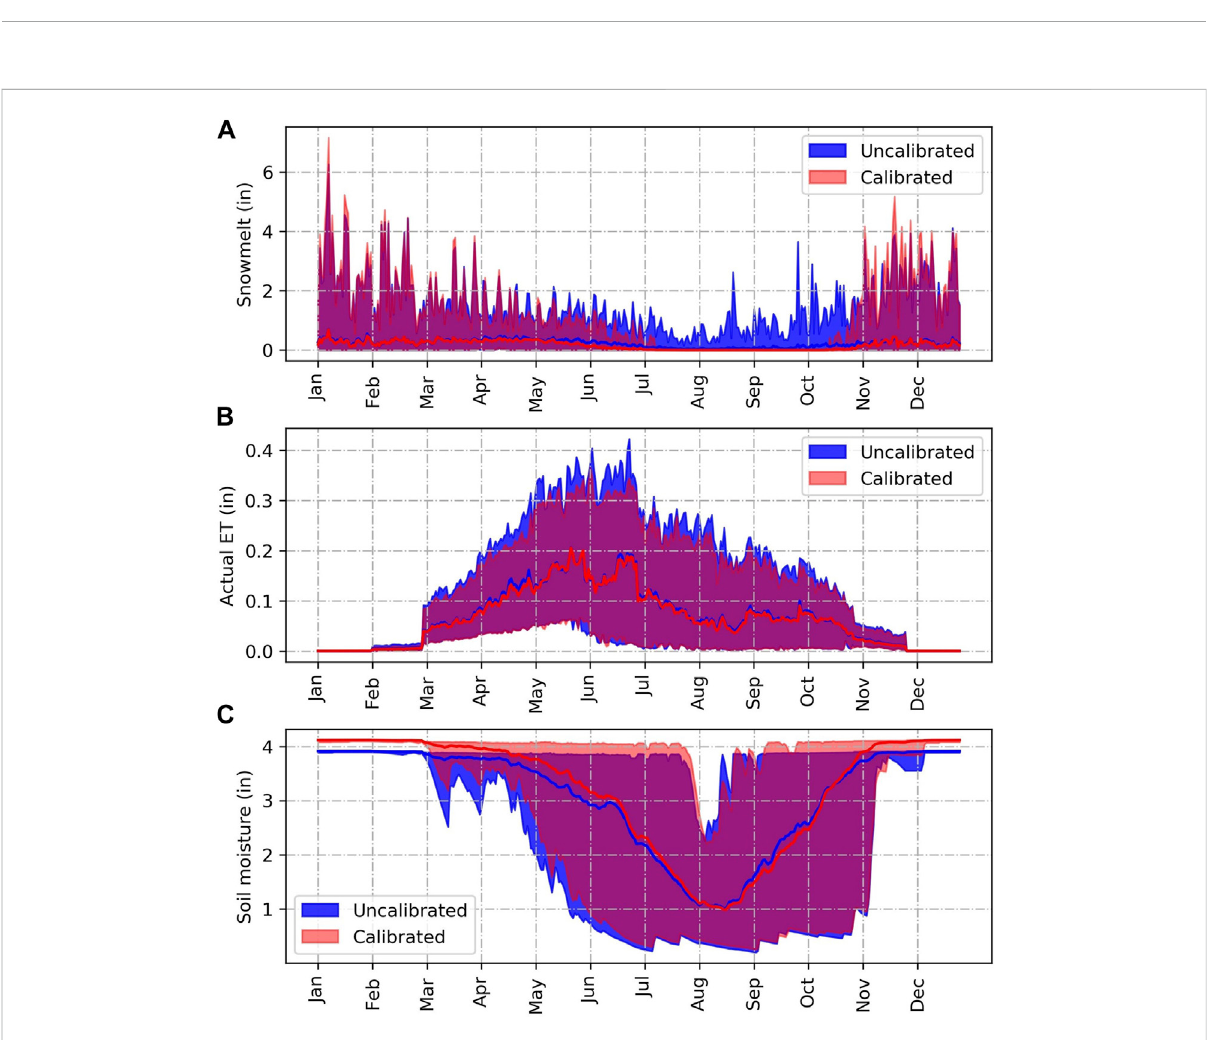
FIGURE 8 Day of the year averages of (A) snowmelt, (B) actual evapotranspiration and (C) soil moisture for both the calibrated and uncalibrated